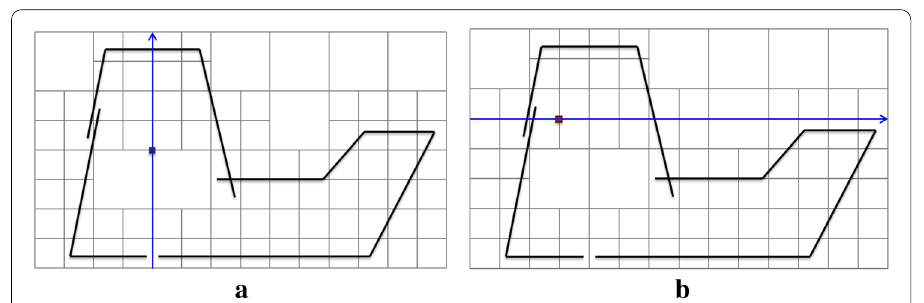
Fig. 30 Errors in the modeled geometry, which lead to an erroneous coloring (wrong identification of inside / outside status). a Situation with gaps. b Situation with overlaps